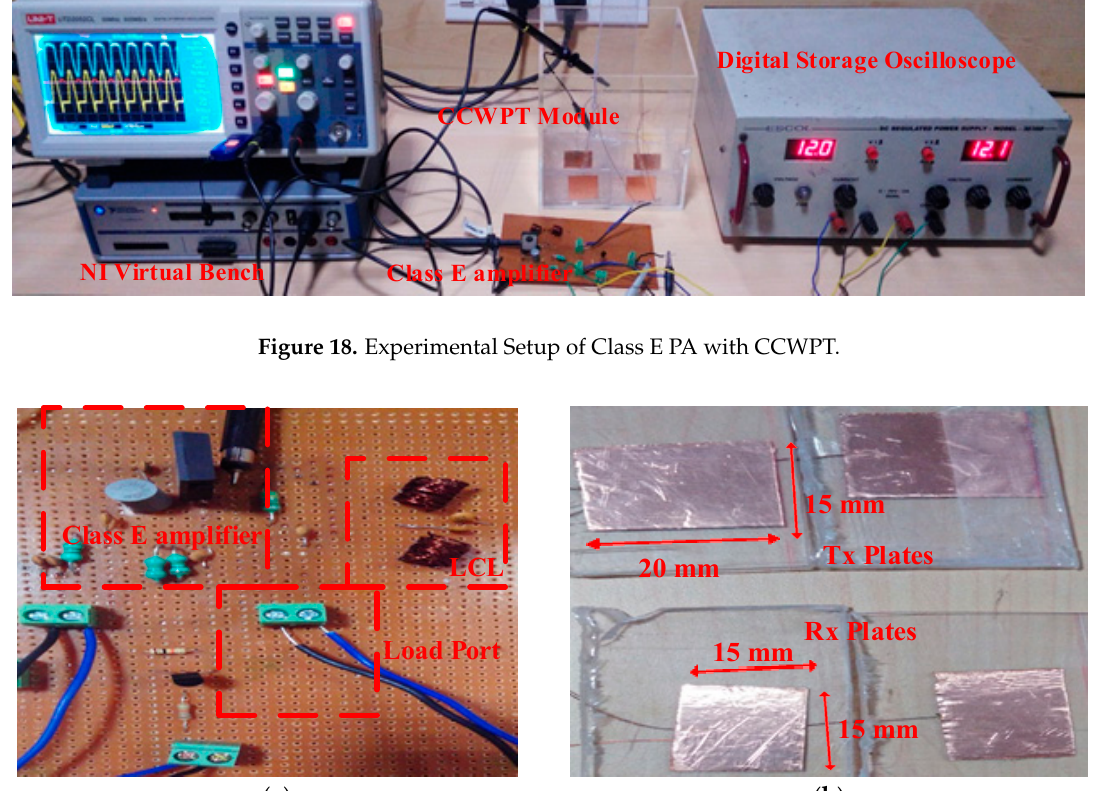
Figure 18. Experimental Setup of Class E PA with CCWPT.